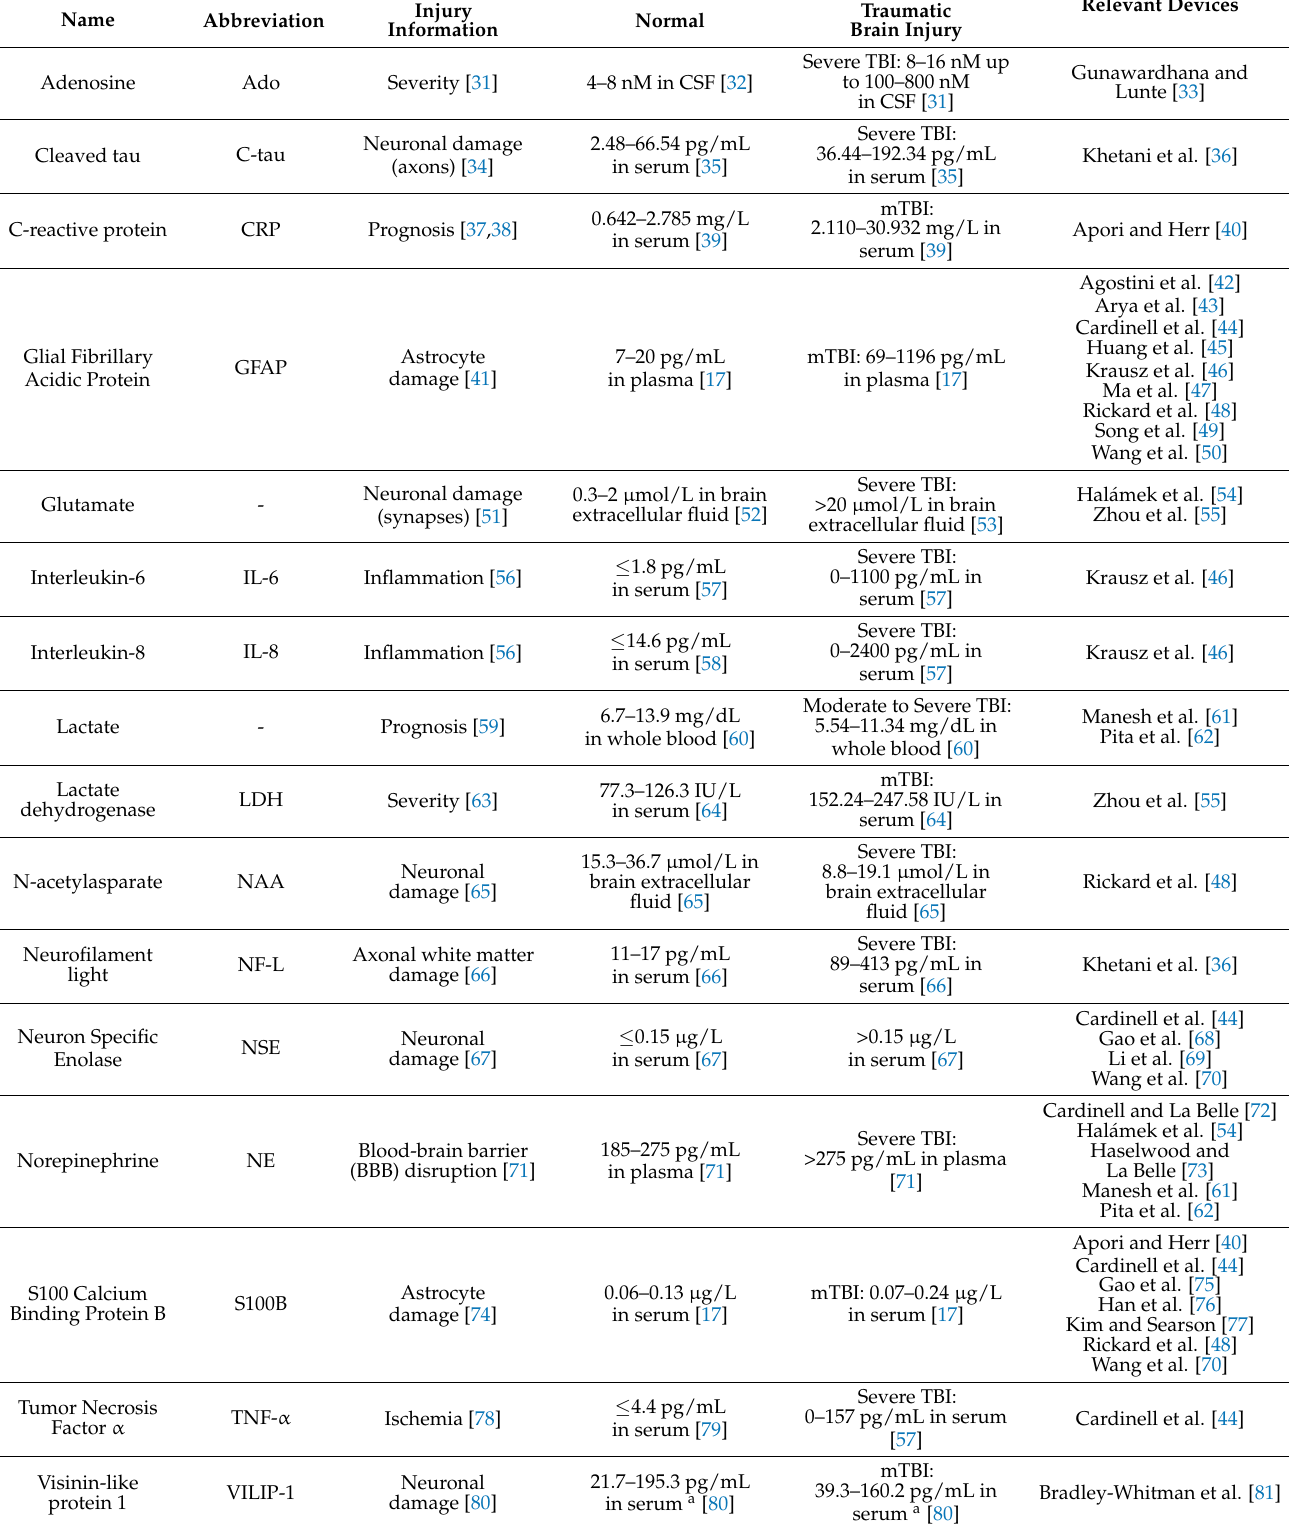
Table 1. Traumatic brain injury (TBI) protein biomarkers measured by the devices included in this